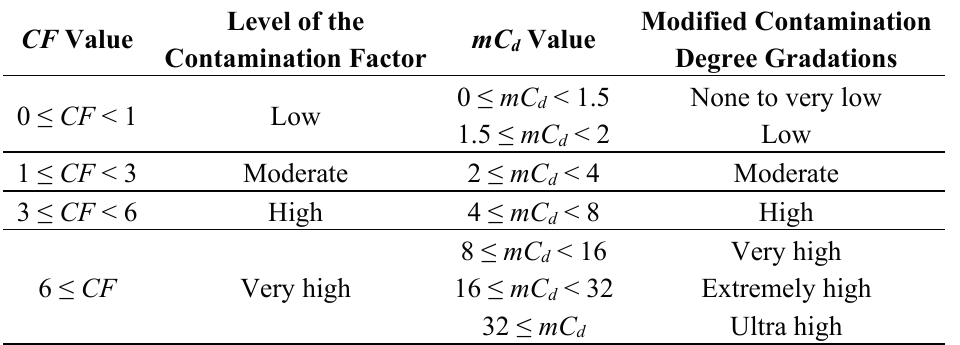
Table 1. Classification and description of the Contamination factor ( CF ) [62] and the Modified contamination degree ( mCd )